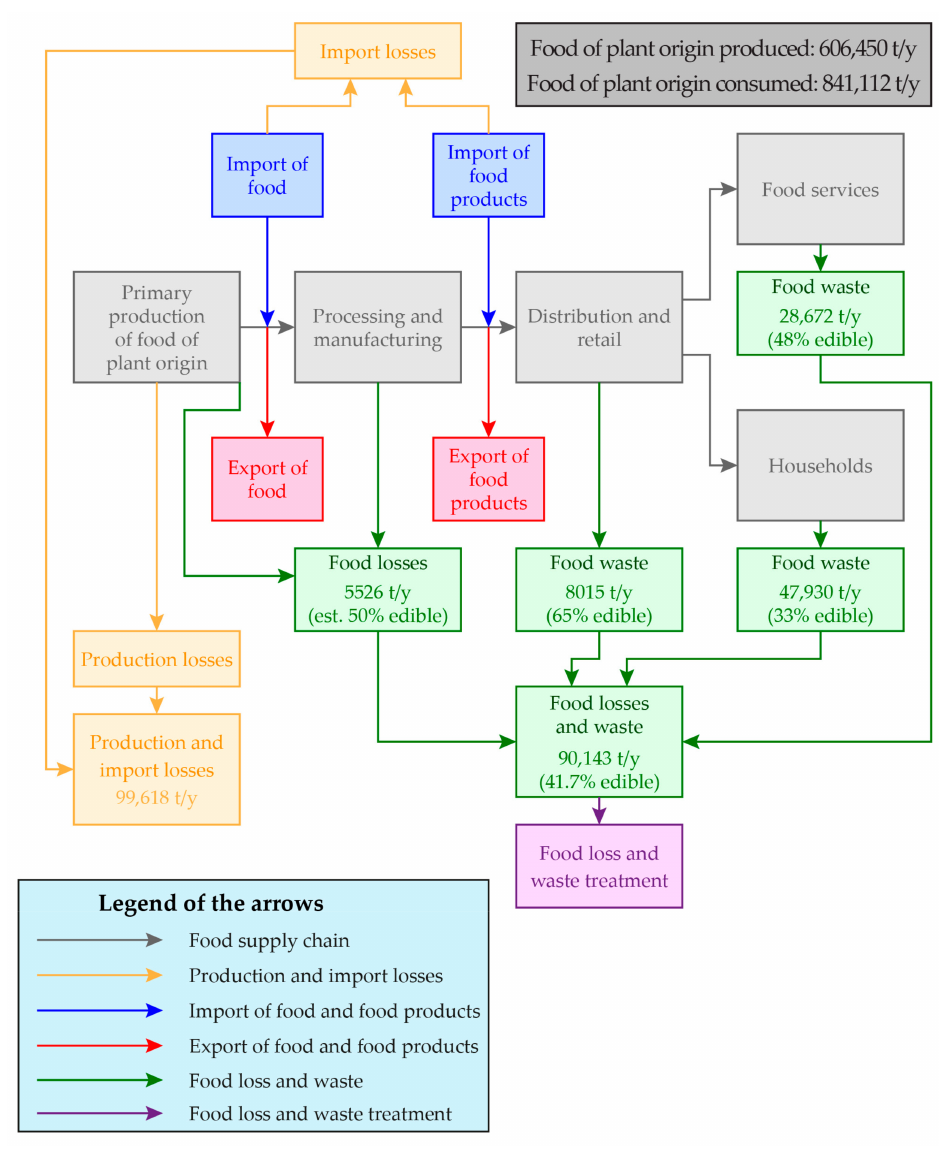
Figure 3. The supply chain for food of plant origin